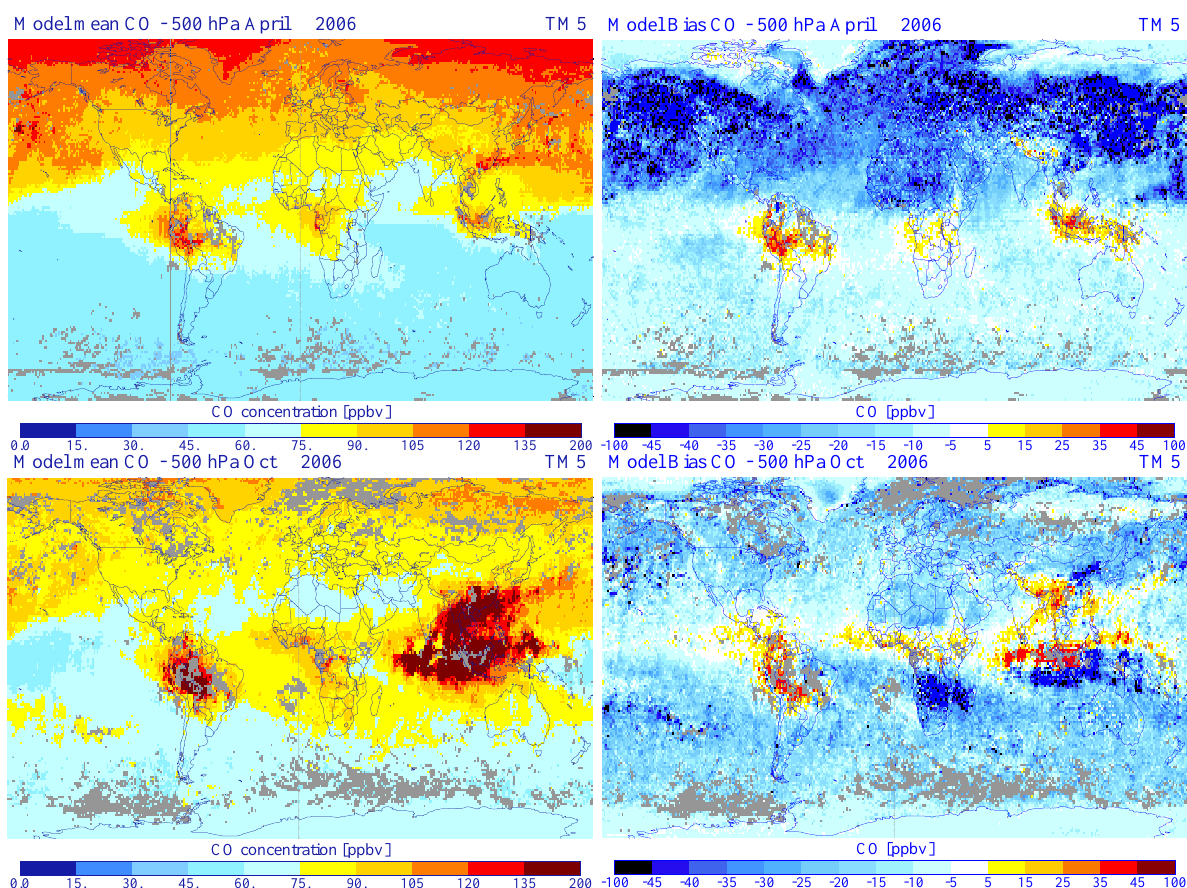
Fig. 4. Mean and bias of TM5 to MOPITT-V4 at 500hPa for April and October 2006, using the same color coding as shown in Shindell et al. (2006). Positive numbers in the bias plots indicate a model overestimate.